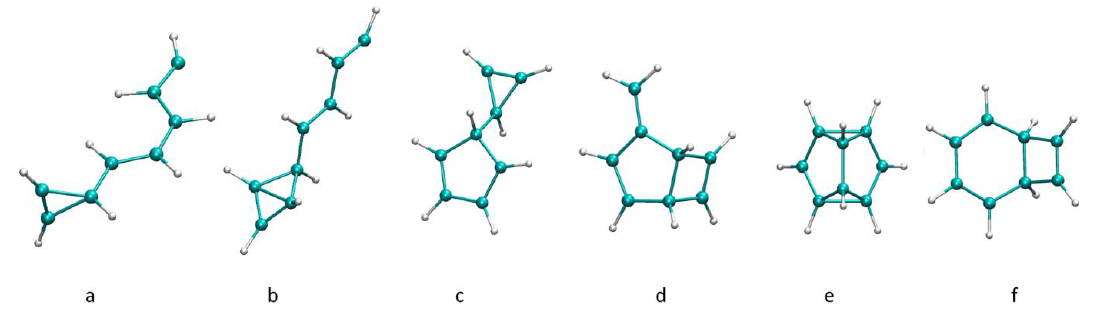
Figure 4. Optimized bonded C 8 H 8+ core structures. ( a–f) : isomers on the C 8 H 8+ PES.